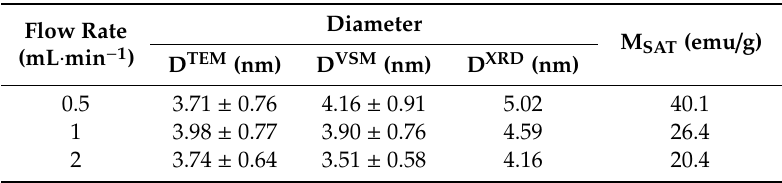
Table 3. Summary of the results obtained with TEM, VSM and XRD for samples obtained in the 2.4 mm capillary reactor.